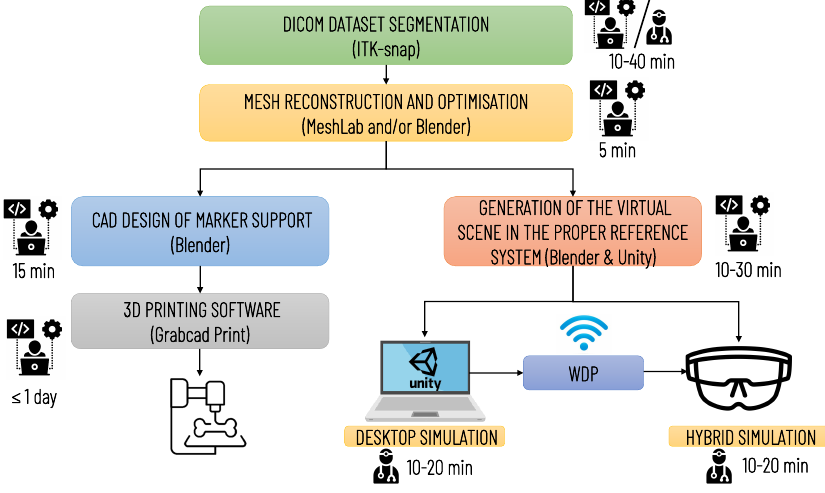
Figure 7. Diagram illustrating the operational steps for implementing the entire simulation and planning platform. The preparation of the simulation requires qualified technical personnel; the segmentation phase can be performed by medical personnel (by a radiologist or the surgeon him- self/herself) or by technical personnel. In the latter case, the final approval of a radiologist is